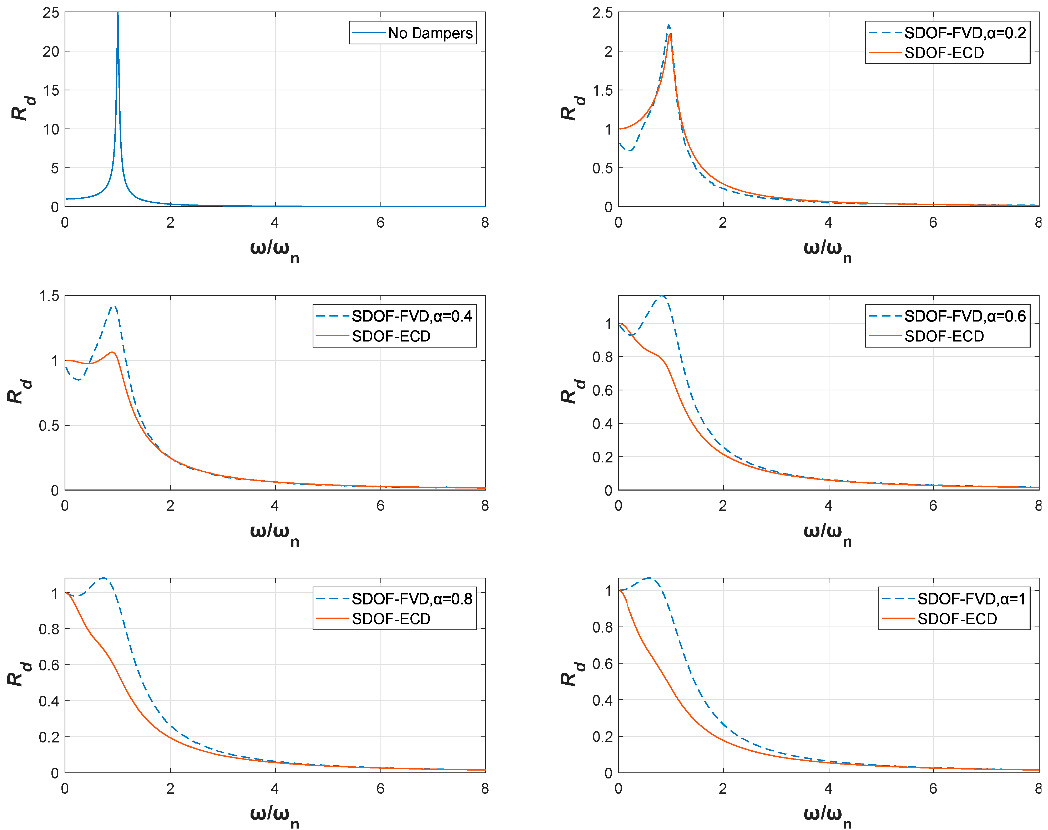
Figure 5. Comparison of displacement response factors for SDOF-ECDs and